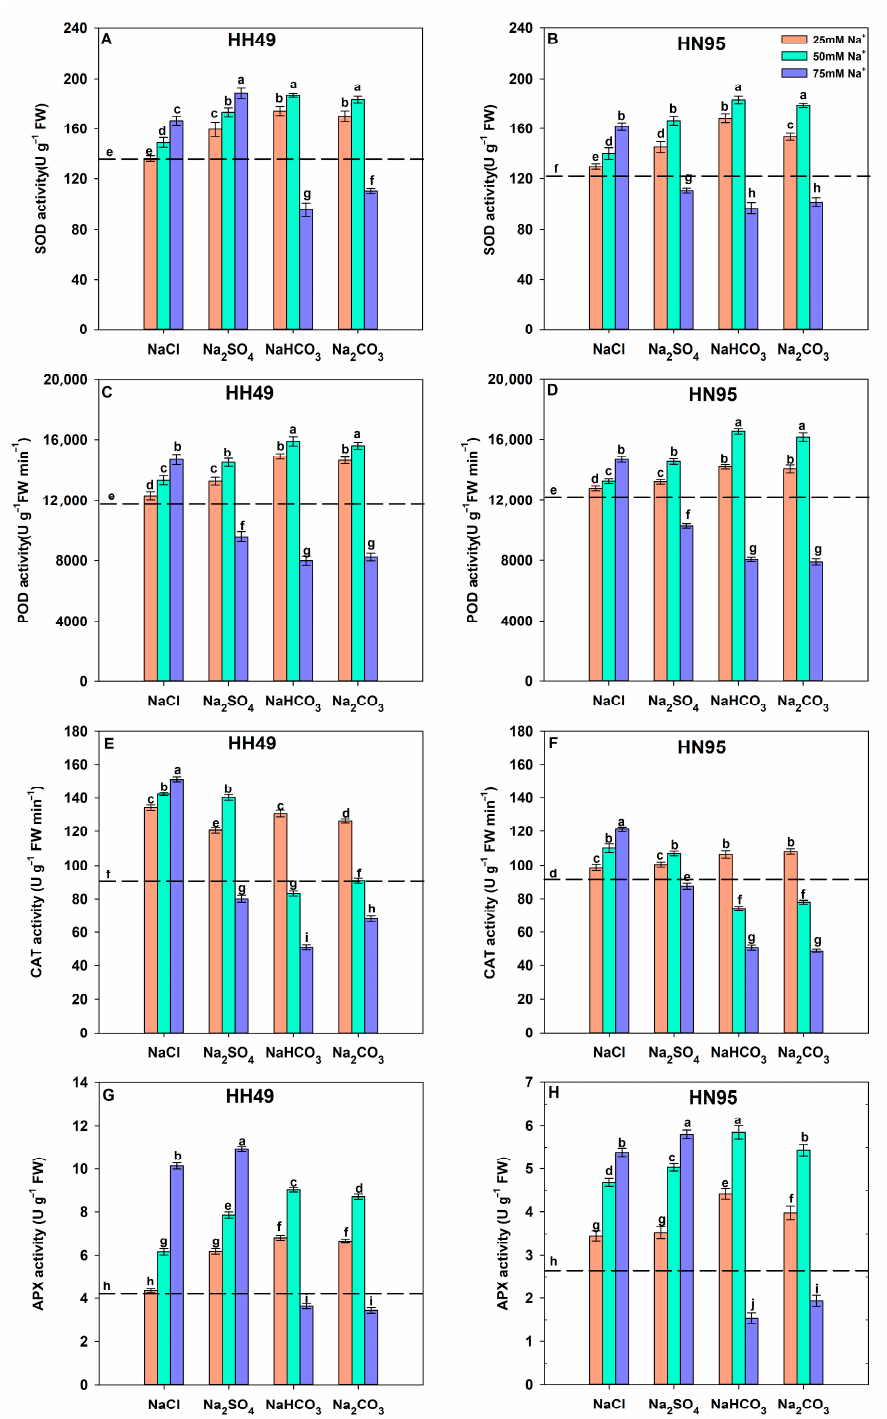
Figure 4. The antioxidant enzyme activity of soybean seedling roots treated with different salt stresses for 3 days. The activities of SOD ( A ), POD ( C ), CAT ( E ), and APX ( G ) in HH49 seedling roots treated with different Na + concentration solutions in formulas of NaCl, Na 2 SO 4 , NaHCO 3 , and Na 2 CO 3 . The activities of SOD ( B ), POD ( D ), CAT ( F ), and APX ( H ) in HN95 seedling roots treated with different Na + concentrations solutions in formulas of NaCl, Na 2 SO 4 , NaHCO 3 , and Na 2 CO 3 . Dashed lines in ( A – H ) indicate SOD, POD, CAT, and APX activities of HH49 and HN95 seedling roots under the control conditions. Data are expressed as means ± SD of three independent experiments. Different letters indicate statistically significant differences ( p < 0.05) among treatments.